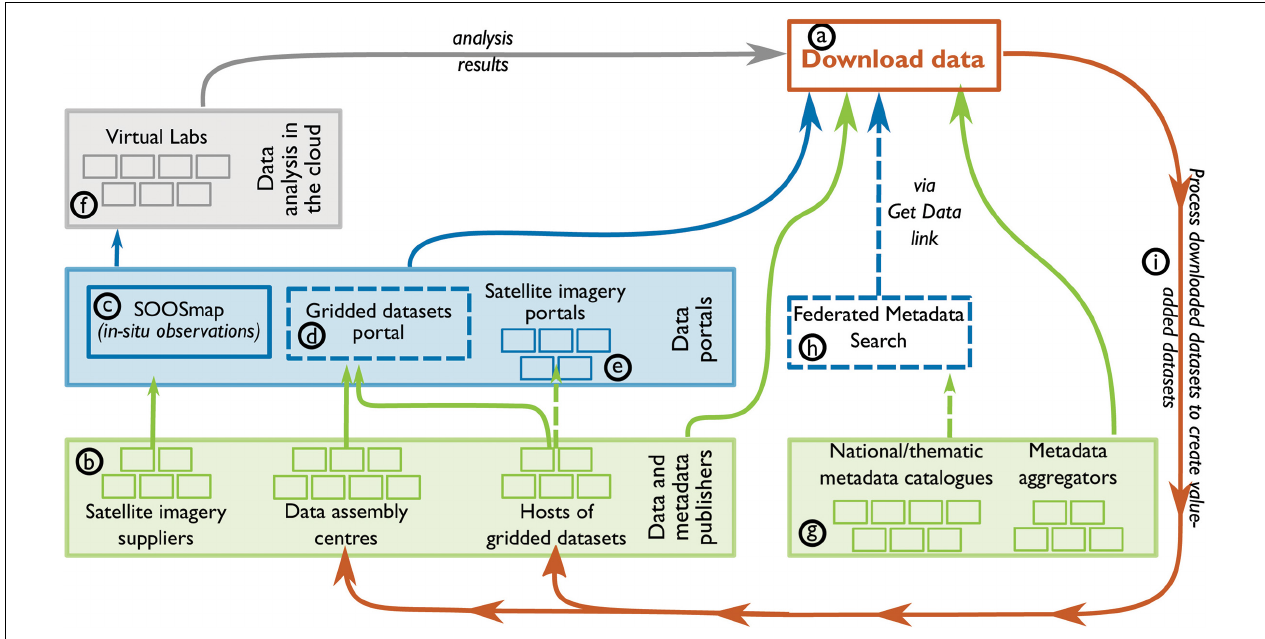
FIGURE 12 | A SOOS-centric view of the data ecosystem. Components that do not exist yet are denoted with dashed lines. (a) Downloading data is possible through multiple paths in this ecosystem; (b) existing data curation services, divided by data geometry; (c) SOOS’ data aggregation portal, SOOSmap, for discovery of in situ observation data; (d) a proposed portal for aggregating gridded datasets for Antarctic regions; (e) aggregation portals for satellite imagery discovery (e.g., NSIDC); (f) virtual laboratories to allow analysis in the cloud rather than creating a local copy of the input data; (g) existing metadata discovery services; (h) a proposed tool to federate searching across all relevant metadata discovery services; (i) in an enclosed data ecosystem, downloaded data can be aggregated, quality-controlled, and converted in value-added datasets that can in turn be fed into the data system.